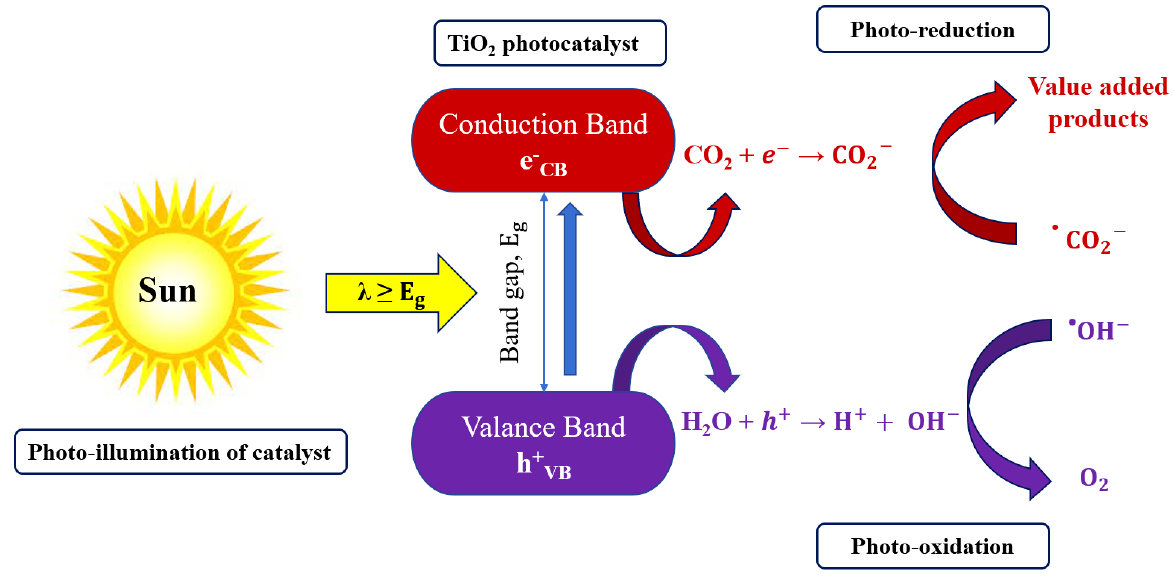
Figure 1. Schematic diagram of photocatalysis process of TiO 2 -based photocatalysts for CO 2 reduc- tion.